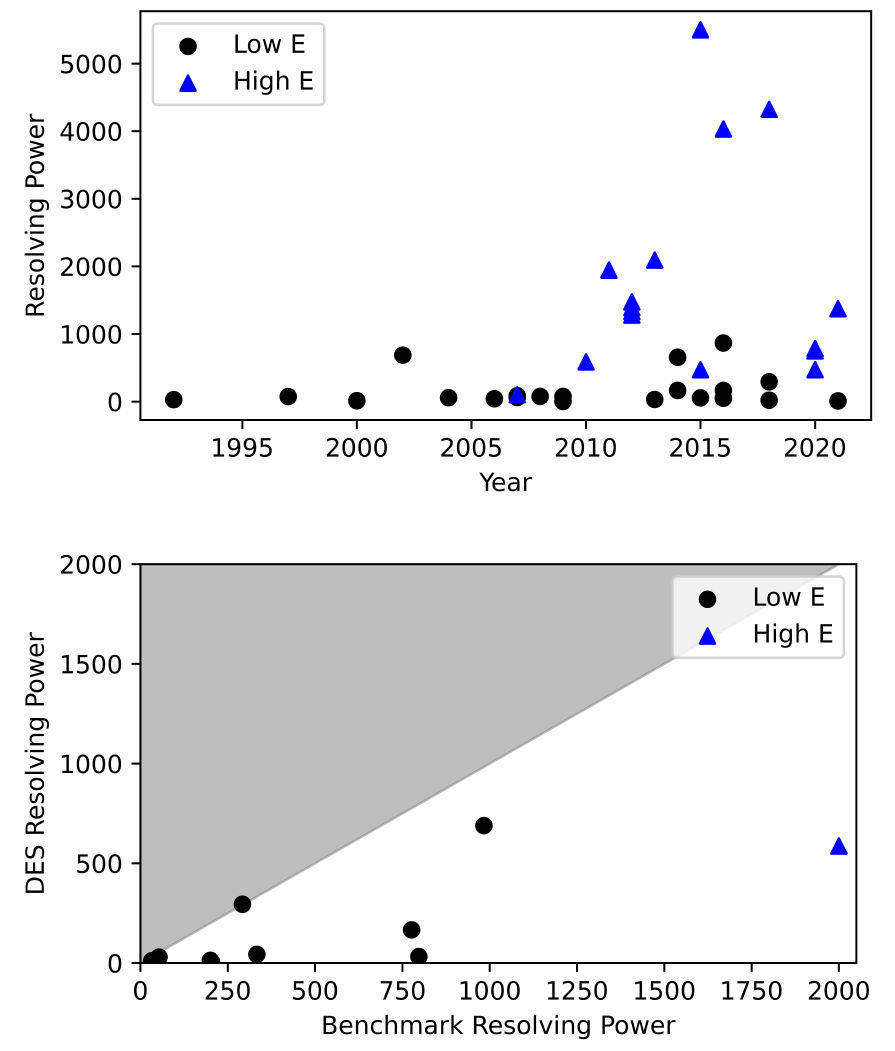
Figure 1. ( Top ) Detector resolving power versus publication date. The first high energy (>2 MeV) DES results occur in 2007 and achieve results exceeding a resolving power of 5000 by 2015. For the low energy (<2 MeV) measurements, the best measurements achieve resolving powers less than 1000. ( Bottom ) The resolving power of DES measurements is compared to benchmark measurements, which correspond to predictions based on the noise or baseline signal, measurements of other radiation such as X-rays or gamma rays, or from prior detector knowledge. In this case, some measurements with very low resolving power are predicted and achieved, but predictions of higher resolving power as is standard with low temperature microcalorimeters were frequently not achieved in these DES